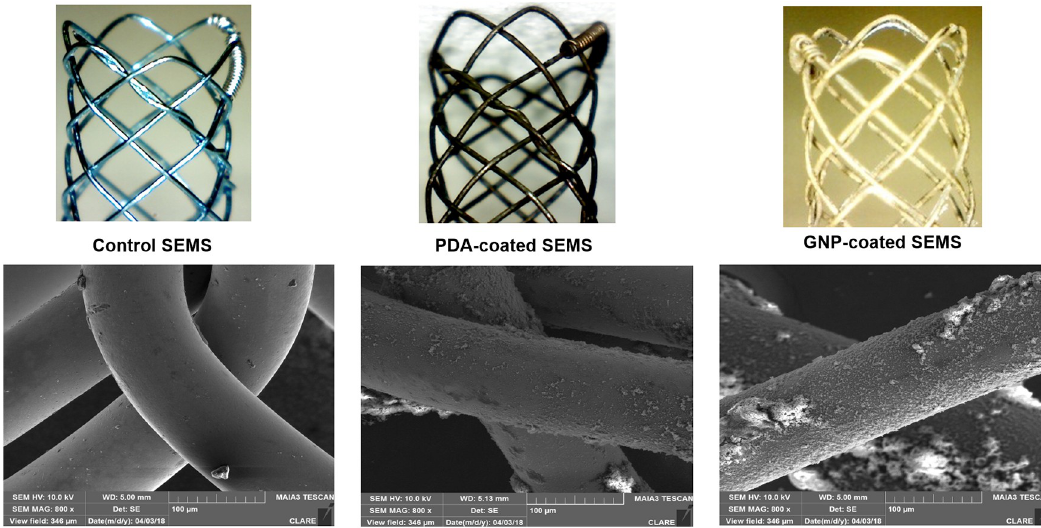
Fig 1. Representative scanning electron microscopy images after the stent coating process. PDA: Polydopamine; GNP: Gold